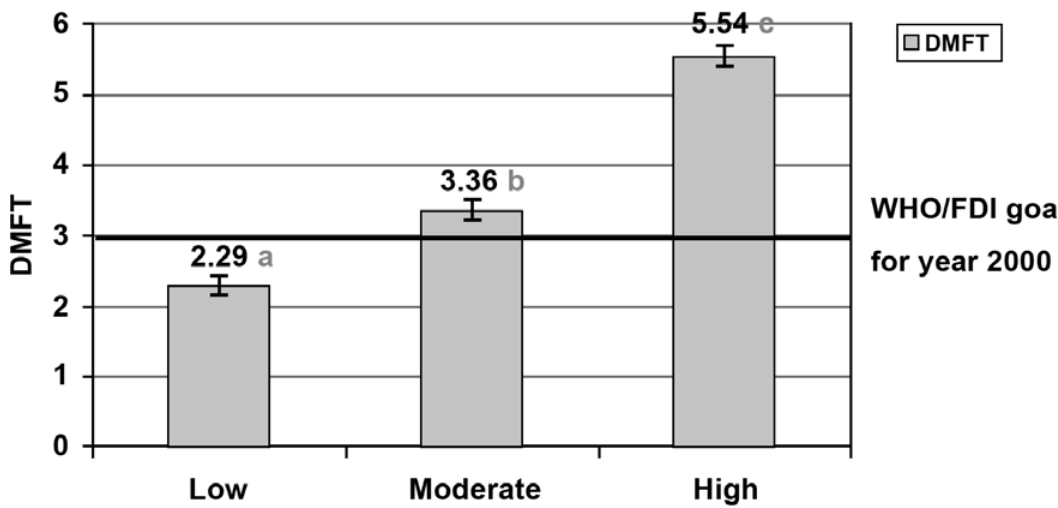
from the region of Campinas, São Paulo State, Brazil (1998 to 2001). Different letters indicate statistically significant difference at 5%